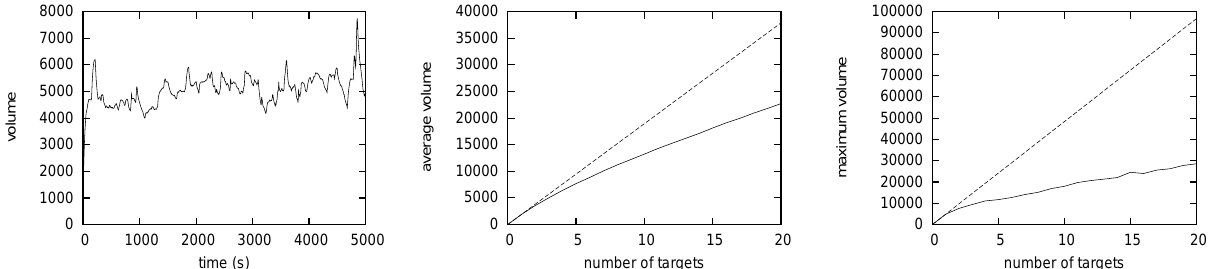
Figure 12 . Simulation results of multiple moving targets.